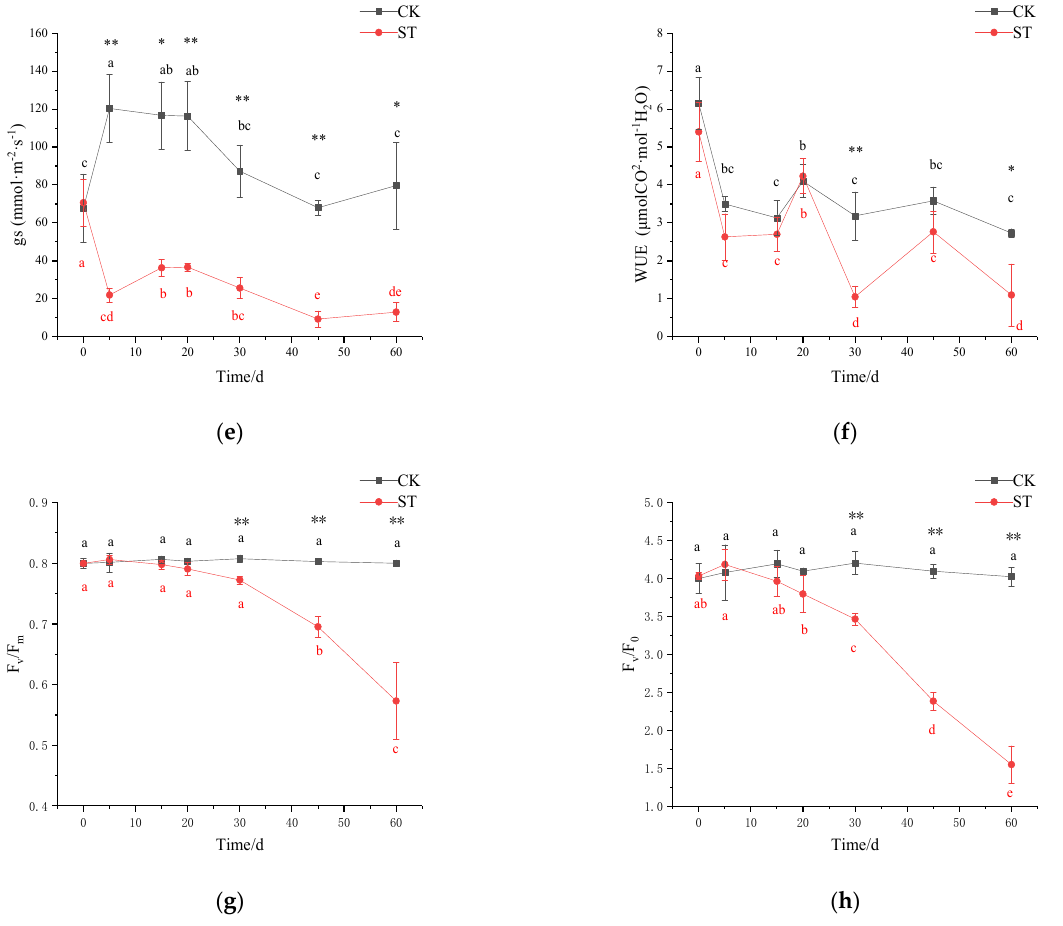
Figure 5. Effect of salinity stress on plant photosynthetic performance of C. hongkongensis subsp. tonkinensis. * and ** indicate a significant difference between CK and ST at the same time ( p < 0.05, 0.01); different lowercase letters indicate a significant difference among the tested time within treatment ( p < 0.05). Black is CK, red is ST. Data missing on the 10th day. ( a ) represents P n –PAR response curves; ( b – f ) represent photosynthetic rate (P n ), internal carbon dioxide concentration (C i ), transpiration rate (T r ), stomatal conductance (gs), and leaf water use efficiency (WUE), respectively; ( g , h ) represent the maximal photochemical efficiency of photosystem II (F v /F m ) and potential activities of PSII (F v /F 0 ). Table 4. Modulations in chlorophyll and carotenoid contents in C. hongkongensis subsp. tonkinensis under salt